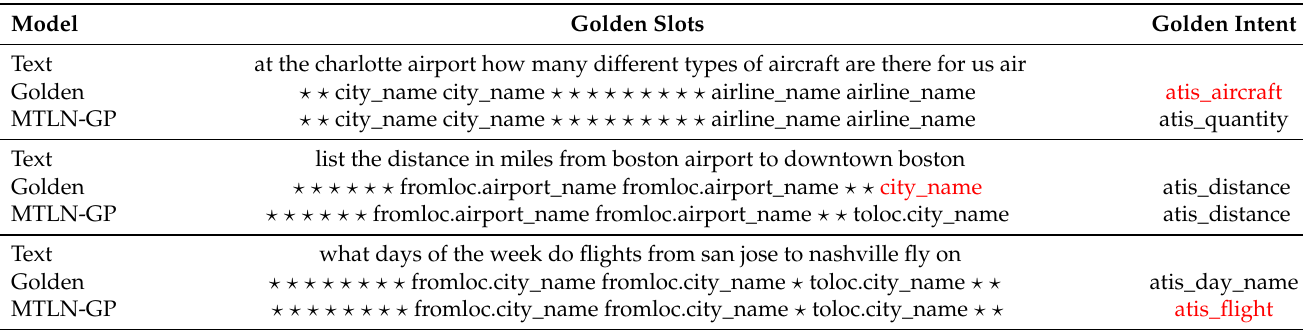
Table 5. The golden label is also included in this example of three testing samples generated by our method on the MixATIS dataset. (cid:63) Indicates that no slot exists at this position. Model Golden Slots Golden